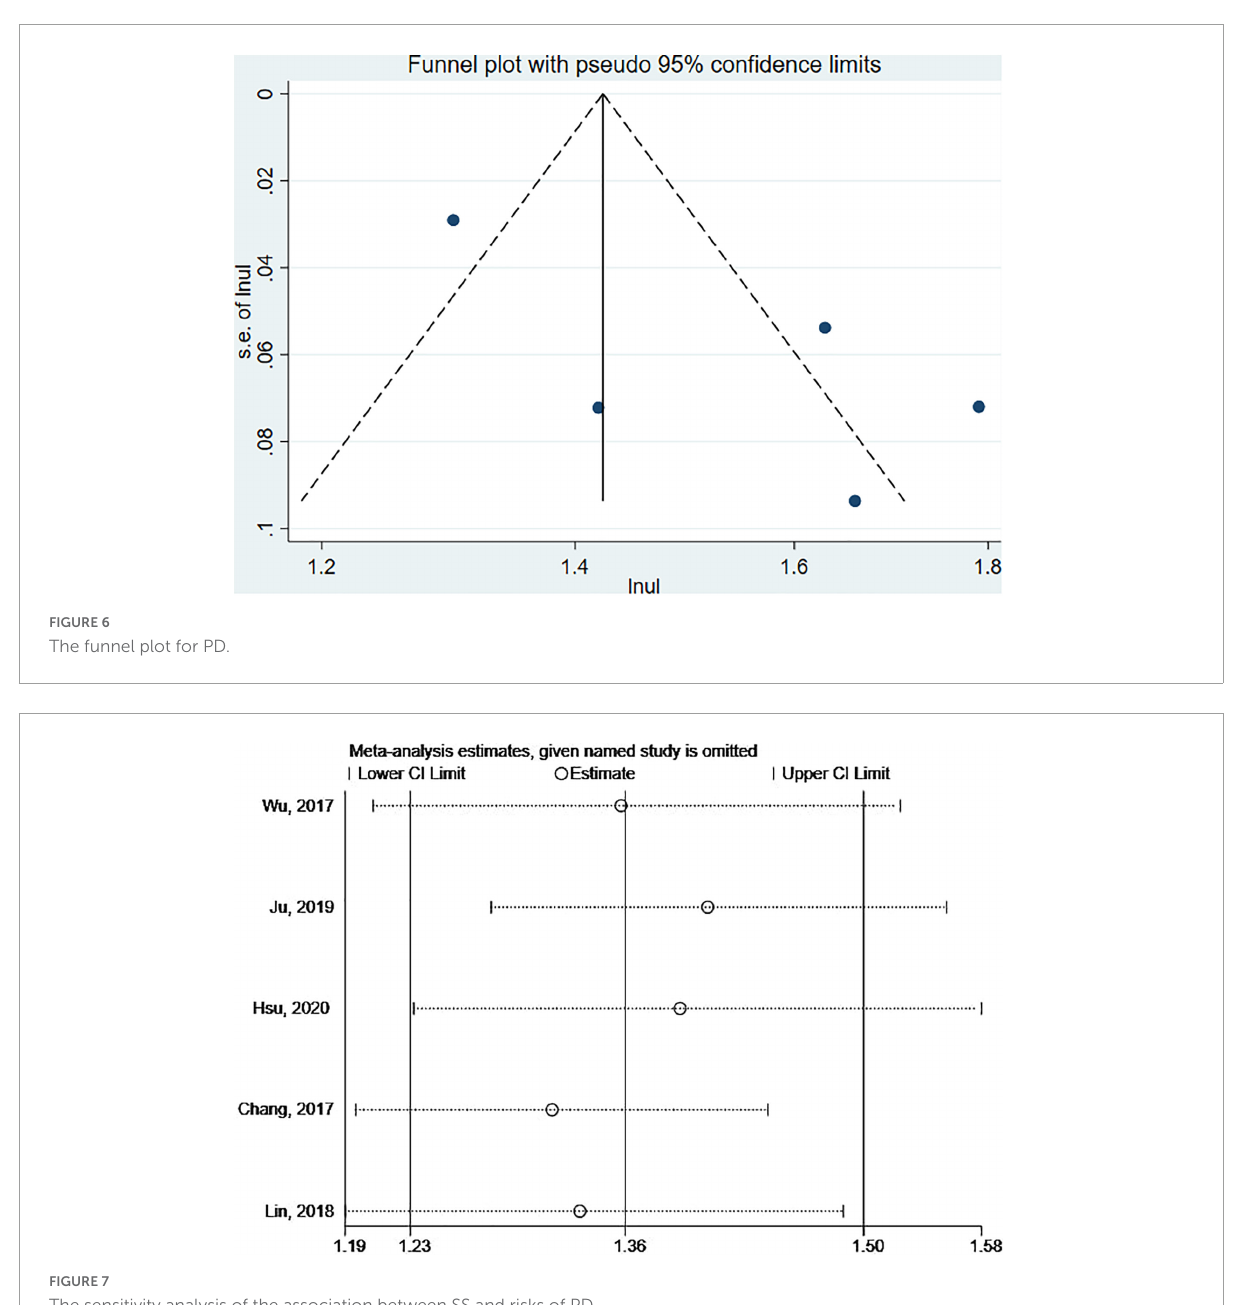
cardiovascular or hypertensive medications in people with these comorbidities (Hou et al.,